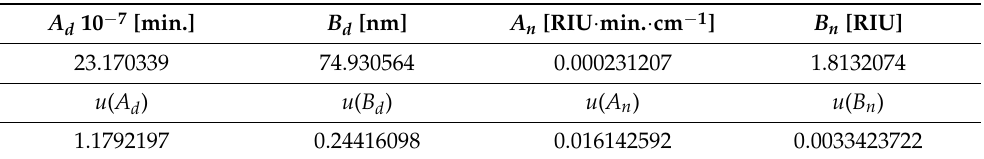
Table 2. Linear regression confidence bands for statistical significance level α s = 0.05 are shown in Figure 1. Table 2. Coefficients of linear functions approximating experimental relationships d ( v ) and n ( v ) and their standard